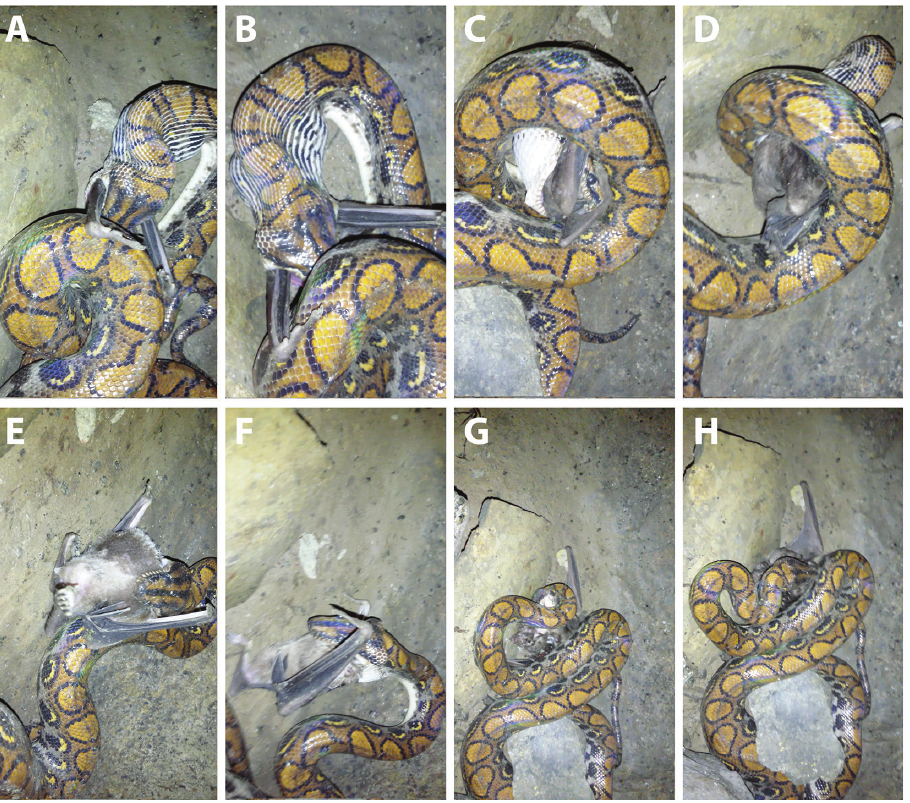
Figure 2. A Rainbow Boa ( Epicrates cenchria ) maintains the prey in the mouth with the interest to make sure it is dead, elongated thumb with three typical bearings evidences the species of the Common Vampire Bat ( Desmodus rotundus ) B E. cenchria releases the dead prey C E. cenchria turns around D. rotundus hav- ing the first attempt to swallow prey D Evidence of sex-age category of the prey, being a female adult; 2e: Starting the second constriction F After the second constriction E. cenchria swallows almost entirely D. rotundus G, H Prey is almost completely eaten except for the wings, but the three typical bearings can be seen on the thumb of D. rotundus